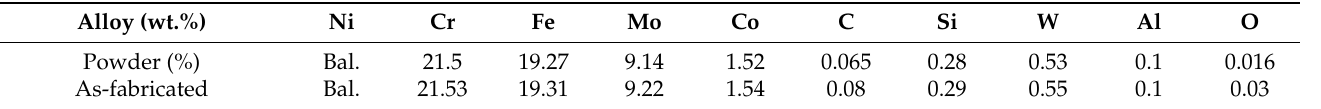
Figure 1. ( a ) LPBF images of the HX powders used in this study; ( b ) particle size distribution diagram of LPBF-HX tensile samples. Table 1. Chemical composition of HX alloys.